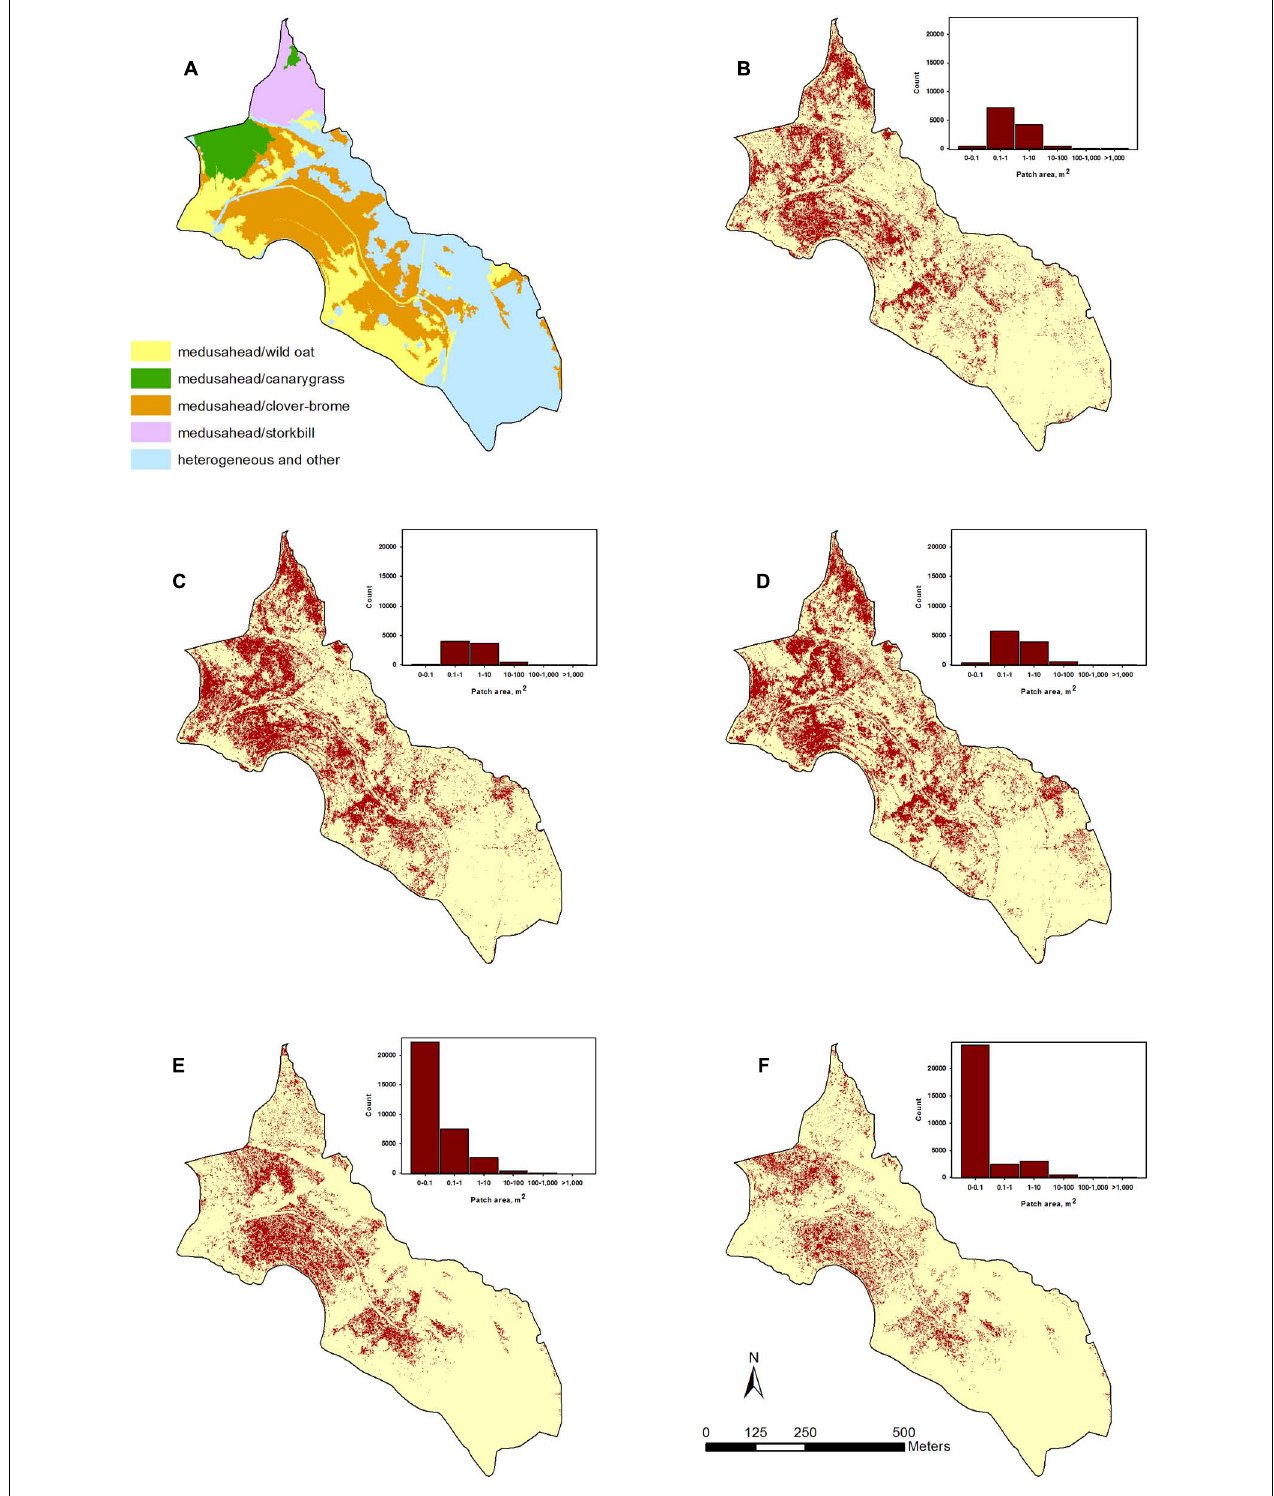
FIGURE 5 | Examples of classified medusahead using: (A) coarser level of the hierarchical classification showing potential medusahead associations with other dominant species; (B) supervised SVM algorithm using seven vegetation classes with spectral and texture attributes; (C,D) supervised Bayesian algorithm using three vegetation classes with and without texture attributes, respectively; and (E,F) finer level of the hierarchical classification using KNN and Bayesian supervised classifiers, respectively.